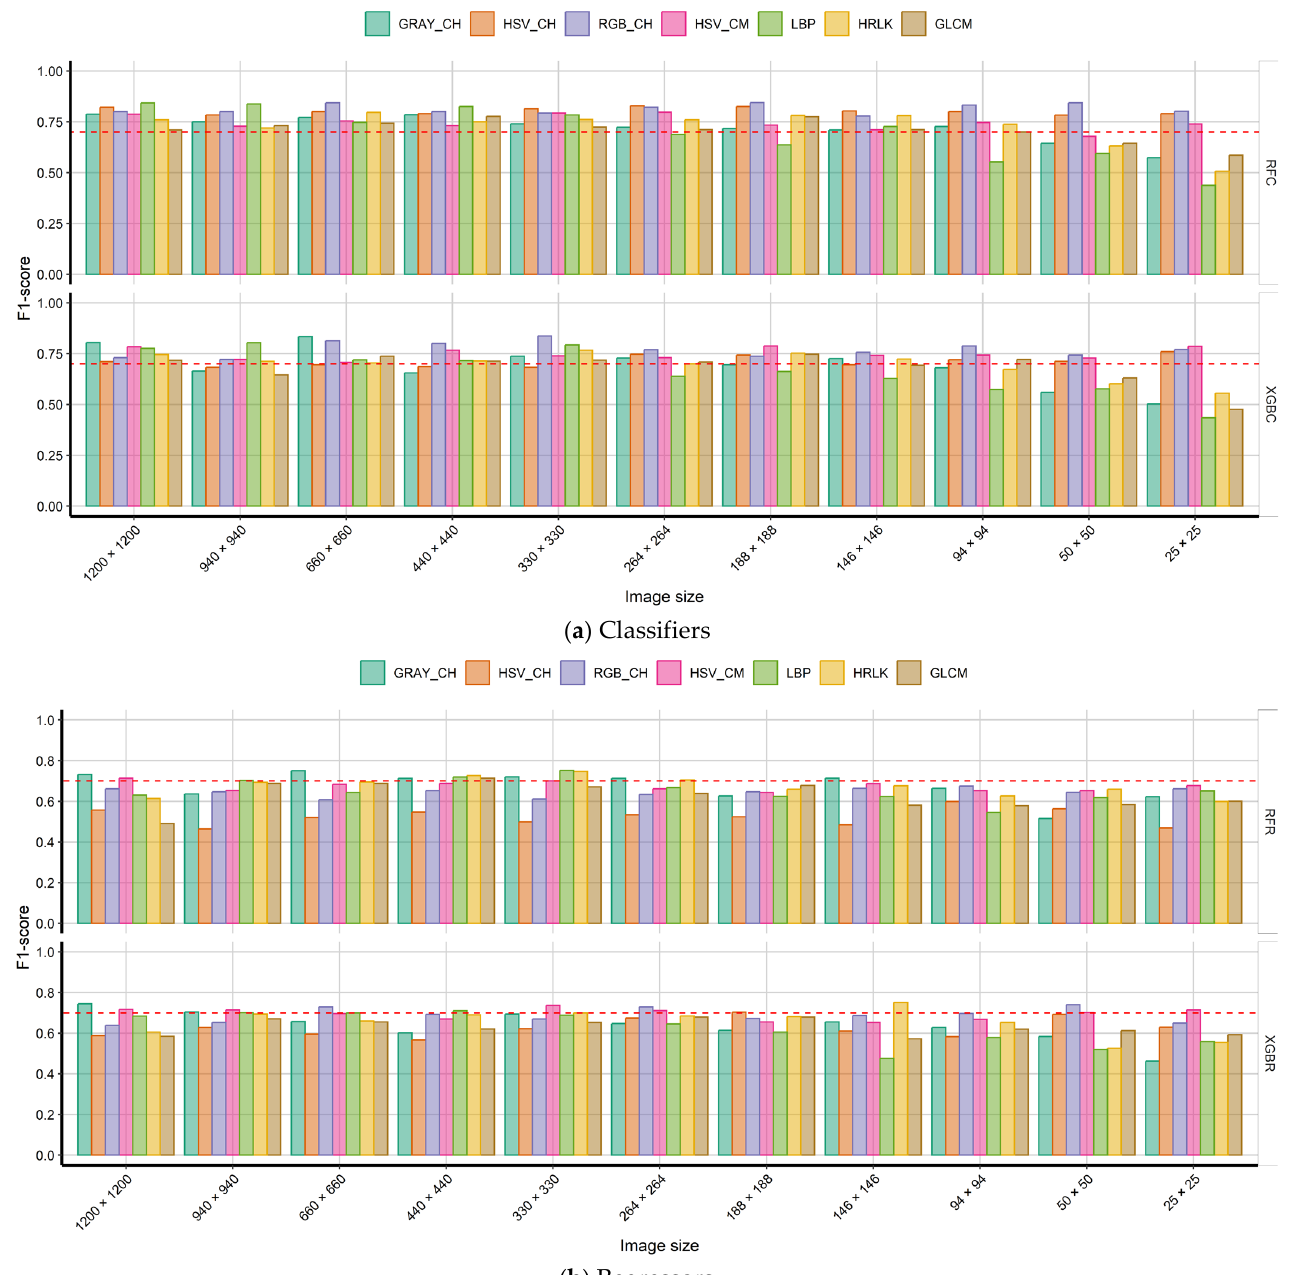
Figure 6. F1-score average performance with global descriptors between classifiers and regressors while cropping the images in dataset G01.